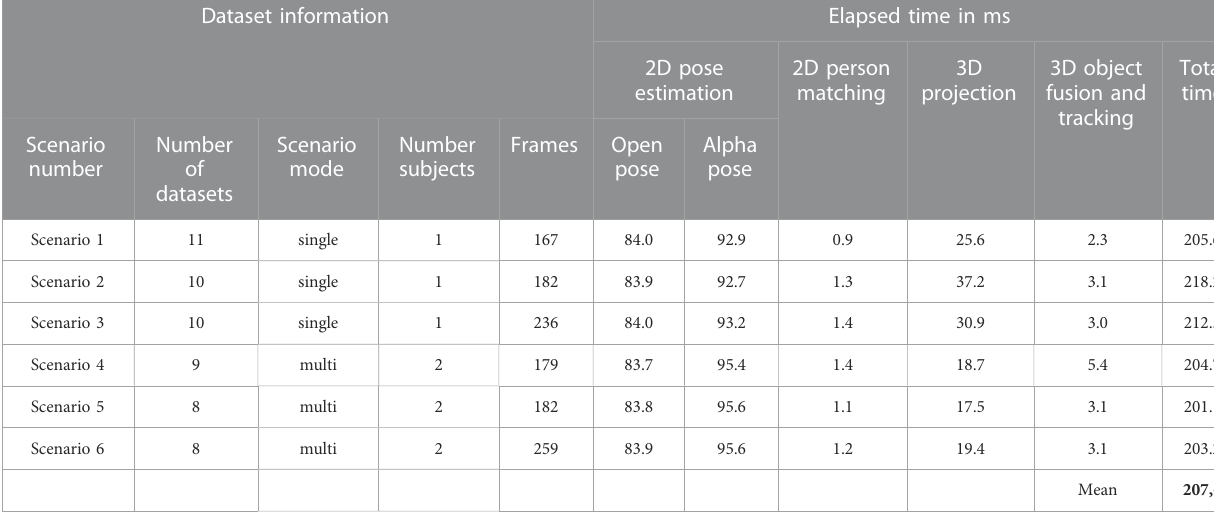
TABLE 4 Summary of the average time measured for each processing step per scenario.